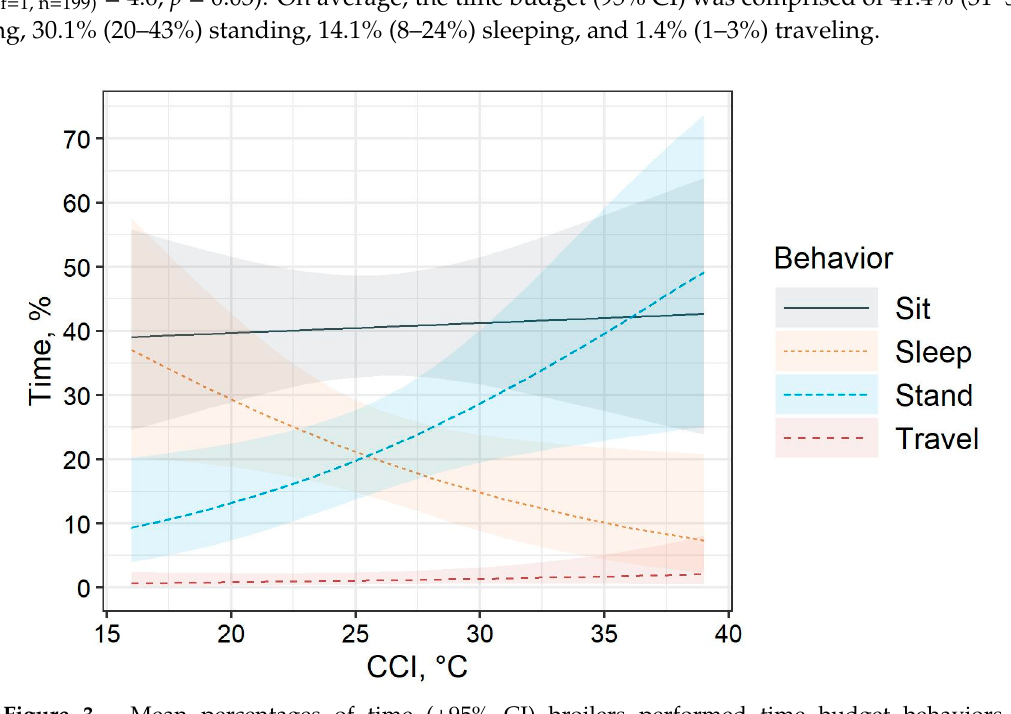
Figure 3. Mean percentages of time (±95% CI) broilers performed time budget behaviors (sitting, sleeping, standing, and traveling) for the effect of CCI. The effect of CCI had p = 0.01 and p = 0.03 for the analyses of standing and sleeping, respectively. CCI = comprehensive climate index, apparent